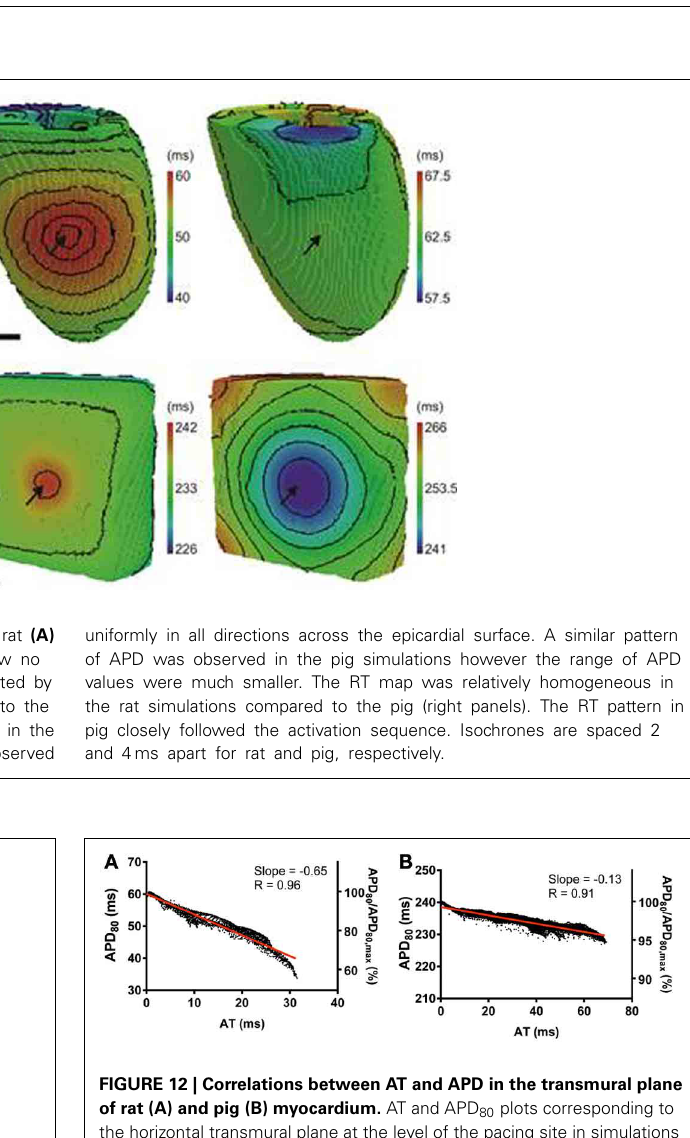
FIGURE 11 | The influence of anisotropy, AP morphology, and tissue geometry on the correlation between activation and APD in simulations. Comparison between slopes of linear correlations for each simulation in Figures 2 , 7–10 .